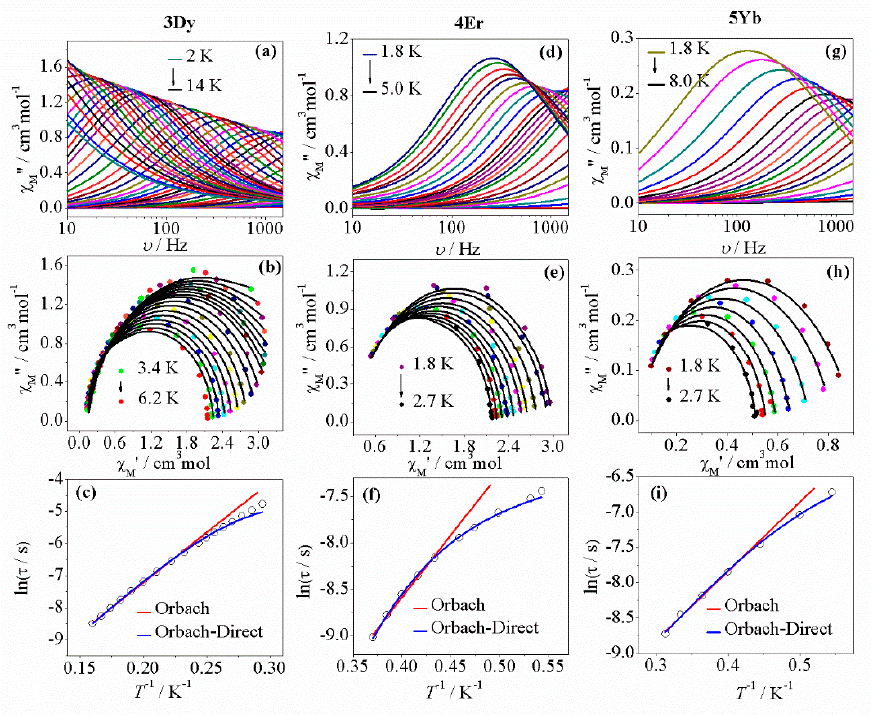
Figure 6. Plot of the ac susceptibility ν s. frequency (out of phase susceptibility) for ( a ) 3Dy , ( d ) 4Er, and ( g ) 5Yb ; Cole–Cole plots of ( b ) 3Dy , ( e ) 4Er , and ( h ) 5Yb ; Magnetization relaxation time, ln( τ ) vs. T − 1 for ( c ) 3Dy , ( f ) 4Er , and ( i ) 5Yb . Red and blue lines represent the fitting using the Arrhenius equation and a combination of direct relaxation processes (see text).